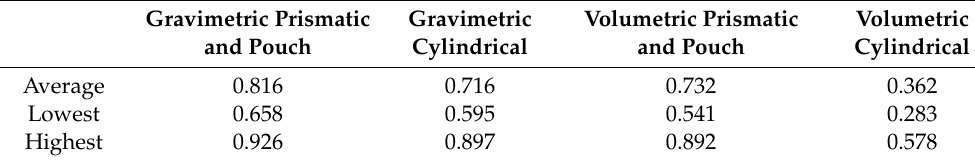
Table 2. E ffi ciency rate of cell level to module level.